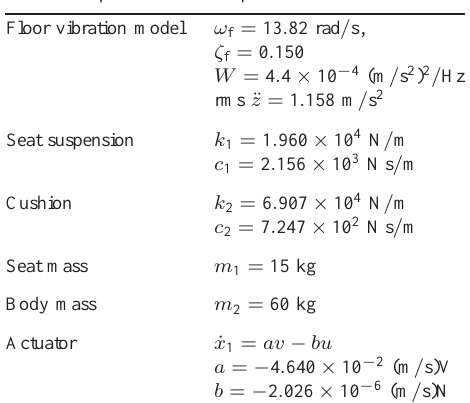
Table 1 Specification of experimental model Floor vibration